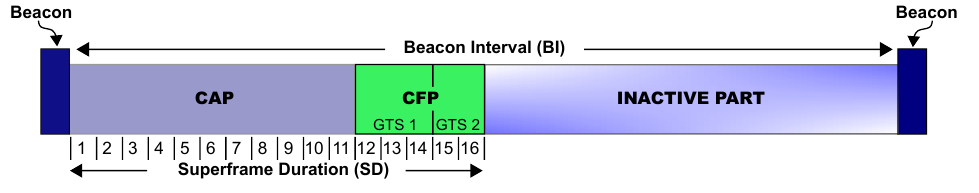
Figure 2. The superframe